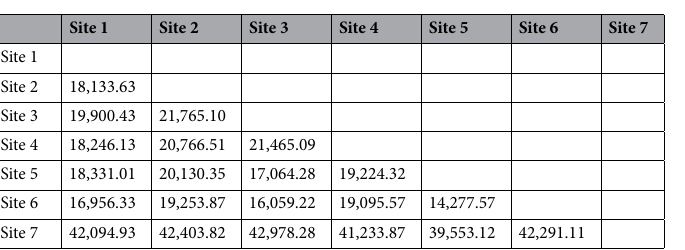
Table 1. Forbenius Euclidian matrix indicating differences among seven on-line monitoring